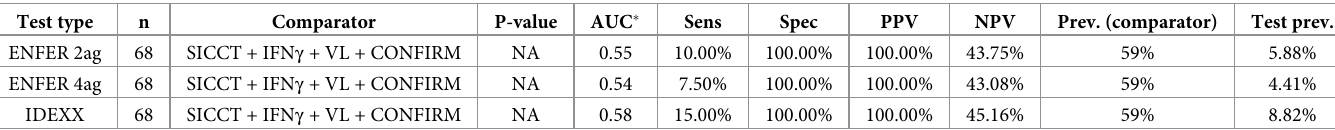
Table 4. The relative performance of serological tests against a combination of statutory ante-mortem and post-mortem diagnostic techniques. Test